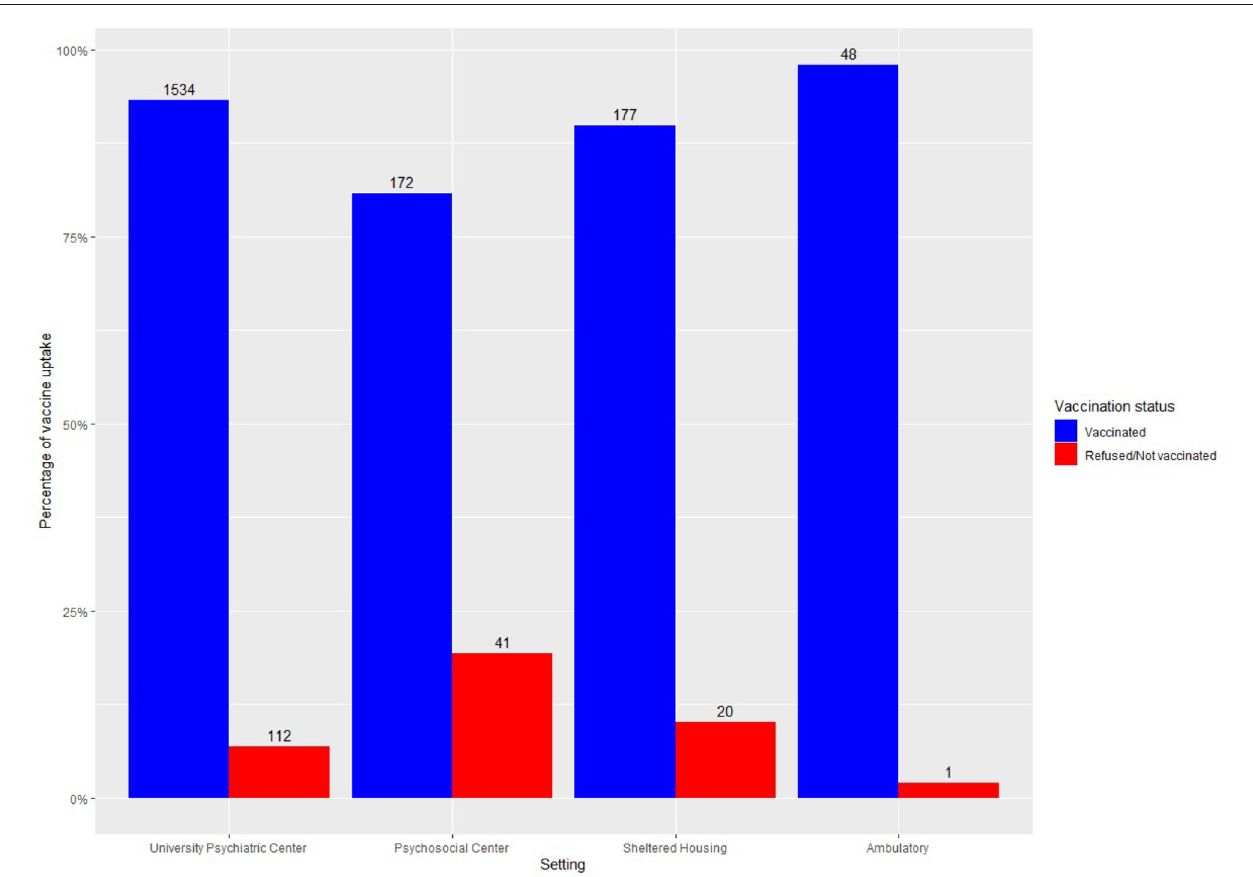
FIGURE 1 | Vaccine uptake in a university psychiatric hospital and in community mental health